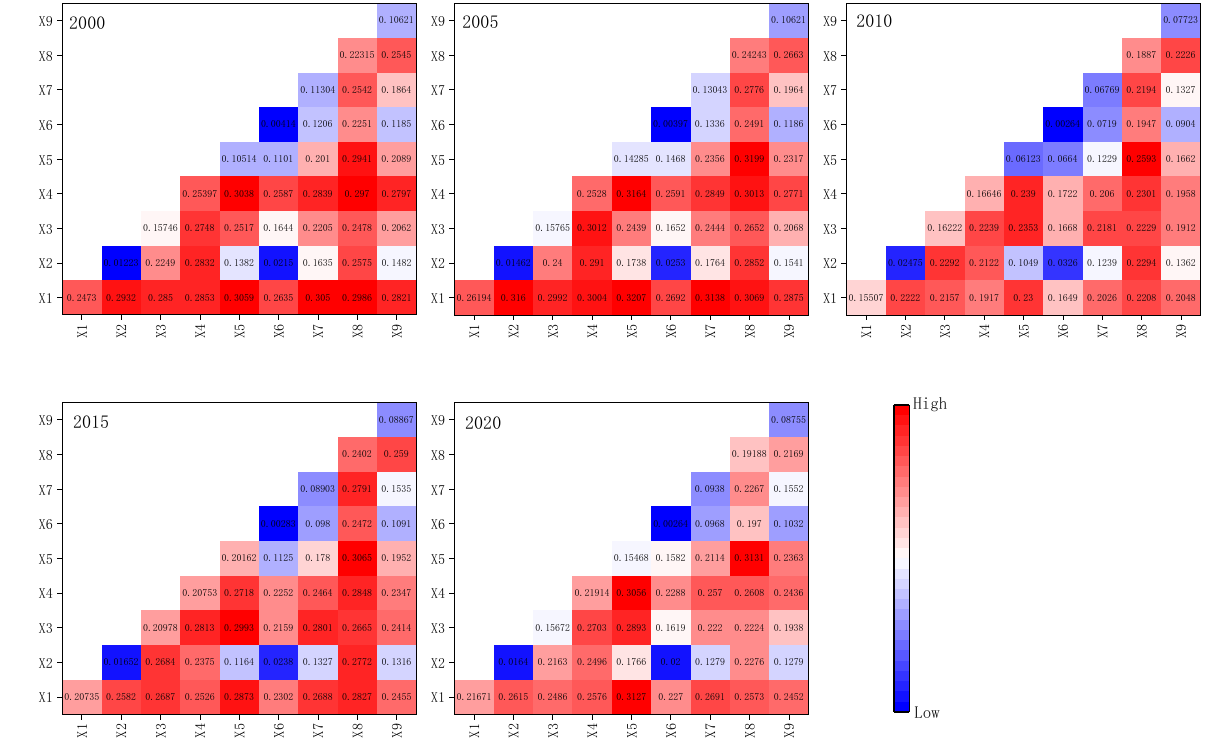
Figure 7. Interaction-driven results of ESVs in Sichuan Province.